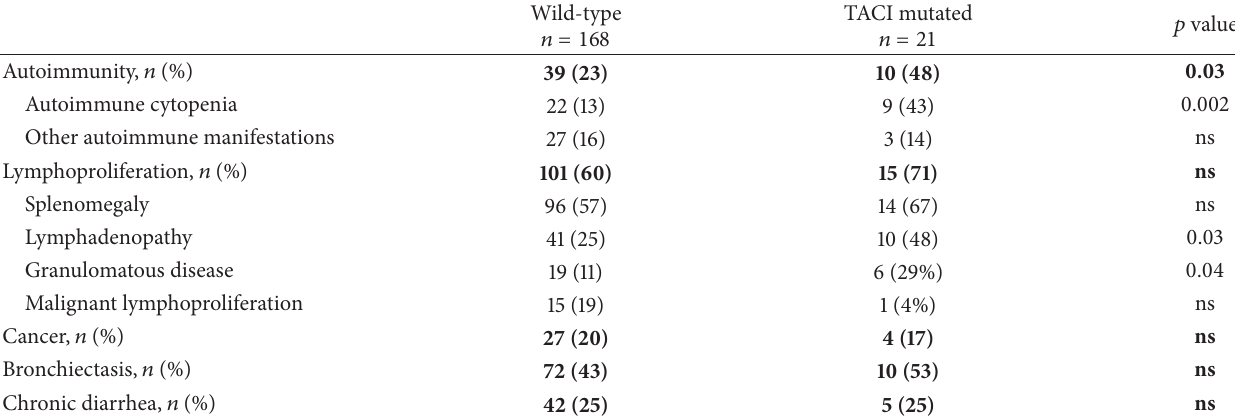
Table 4: Frequencies of clinical complications in patients with wild-type and TACI-mutated CVID.